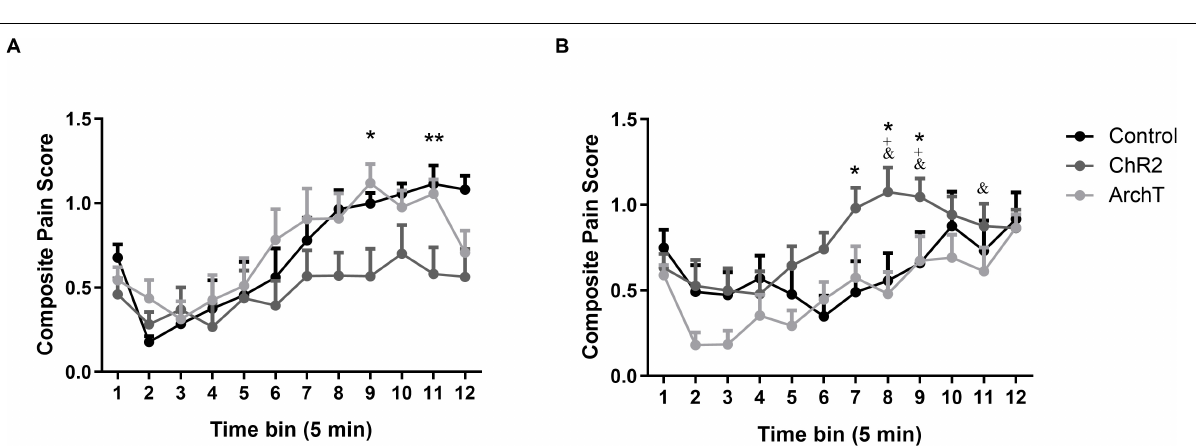
in the Female-ChR2 group was significantly higher than in Male-ChR2 counterparts at time bins 8 and 9 ( p <